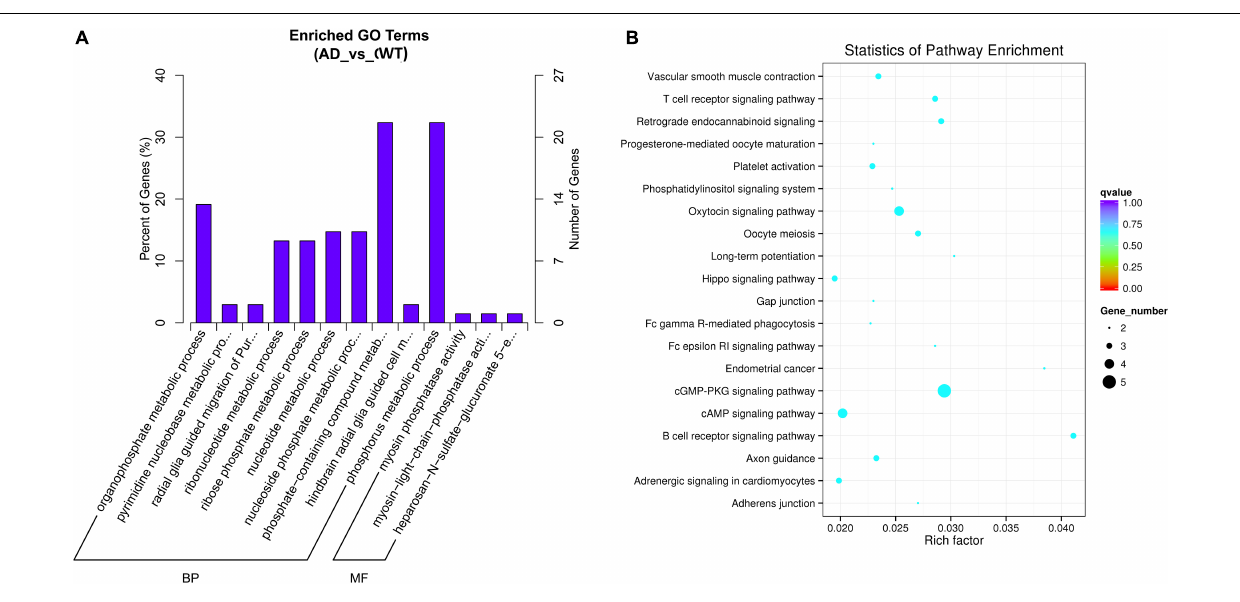
Table 4 ). The ceRNA network covered two cases: one was miRNAs downregulated in APP/PS1 mice)-mRNA (3 mRNAs upregulated in APP/PS1 mice), and the other was circRNA (4 circRNAs downregulated)-miRNA (4 miRNAs upregulated)- mRNA (5 mRNAs upregulated). These circRNA-miRNA-mRNA interactions may supply a novel perspective for the